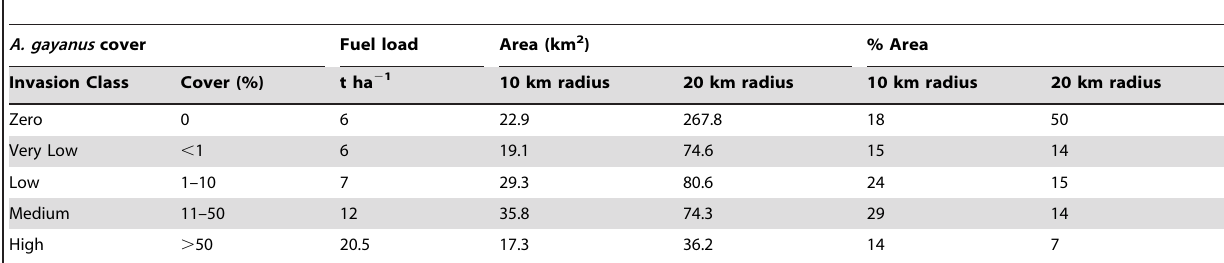
Table 2. The cover and equivalent fuel load of A. gayanus in the surveyed in the Coomalie Shire, NT.